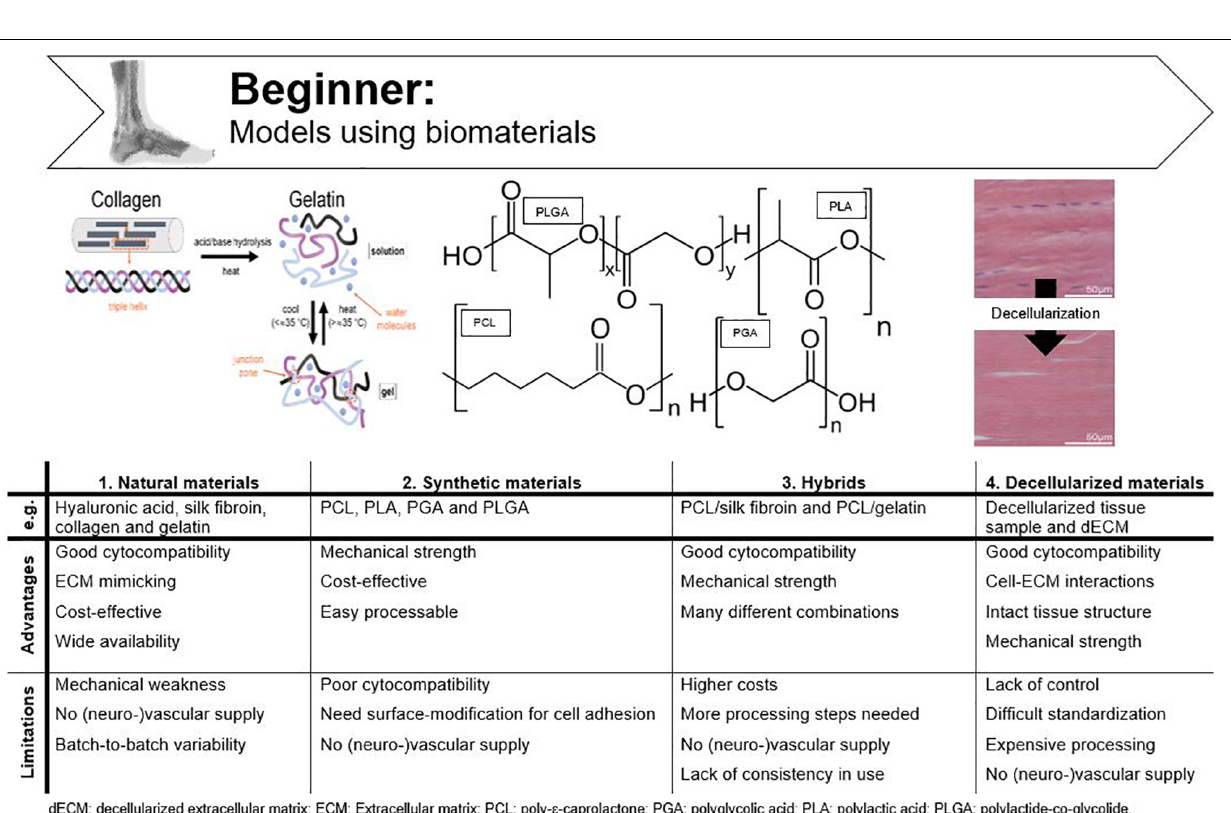
Frontiers in Cell and Developmental Biology |